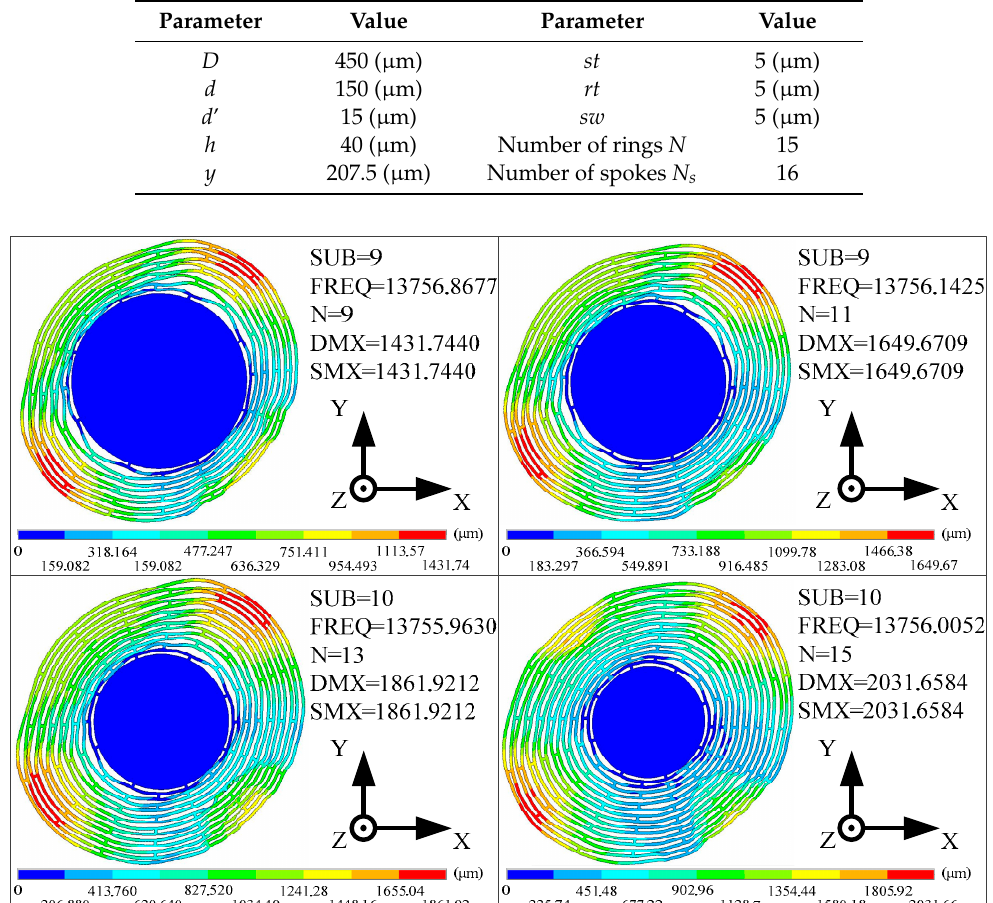
Figure 12. The operating modes of the sample resonator with different ring numbers.